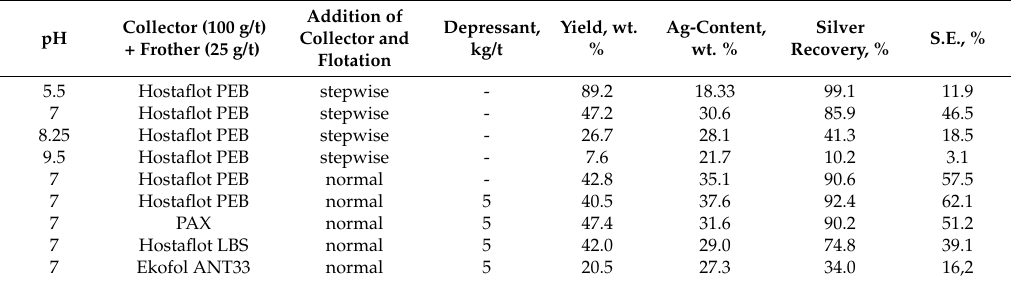
Table 4. Effect of pH value and type of collector on the selective froth flotation of silver sulfide minerals (Yield = mass output in relation to input, S.E.: Separation efficiency). Addition of Collector (100 g/t) pH Collector and + Frother (25 g/t)